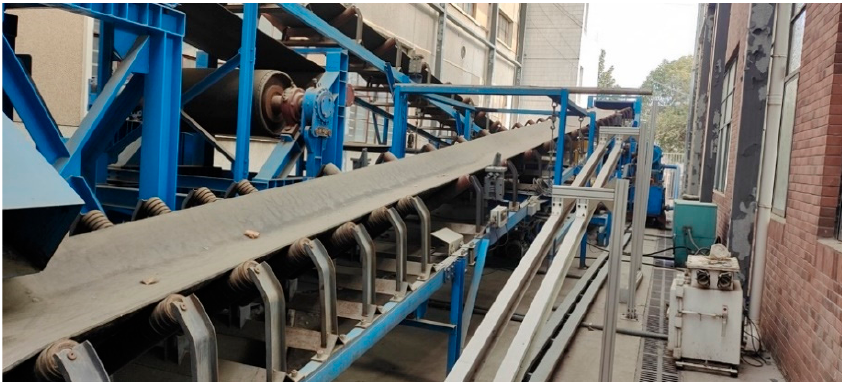
Figure 5. The belt conveyor in the laboratory simulation environment.